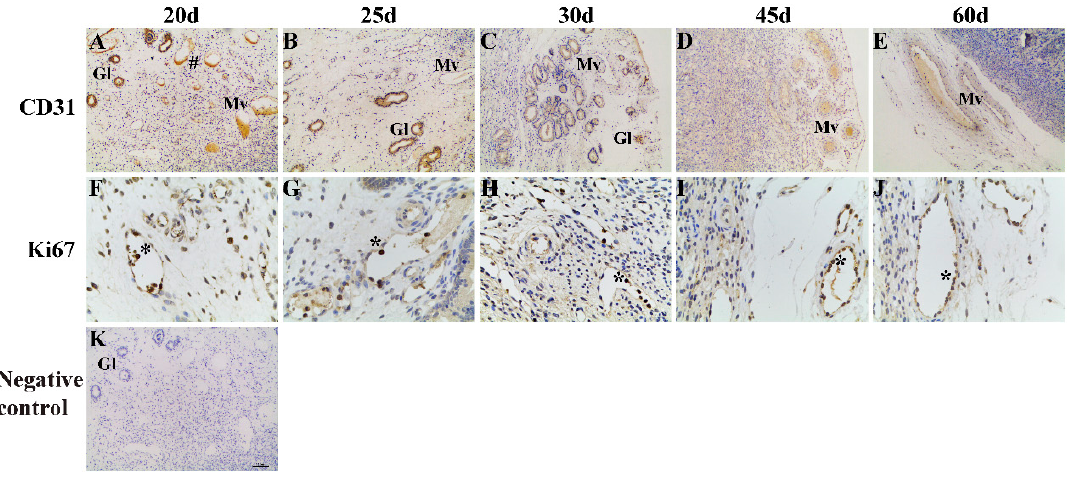
Figure 1. Representative photomicrographs of immunohistochemical staining for CD31 and Ki67 in the goat caruncle. ( A – E ; 100×). Apparent immunoreactive CD31 ‐ positive vessels labeled on days 20 ( A ), 25 ( B ), 30 ( C ), 45 ( D ), and 60 ( E ) of pregnancy. ( F – J ; 400×). Higher density of Ki67 (black arrows) in the nuclei of endothelial and perivascular cells from goats on days 20 ( F ), 25 ( G ), 30 ( H ), 45 ( I ) and 60 ( J ) of pregnancy. ( K ; 100×). Negative control in caruncle on day 20 of pregnancy; no staining was observed. Pound sign indicates staining of CD31 in the caruncle; Mv = maternal vessels; Gl = uterine glands; Asterisks indicate staining of Ki67 in the endothelial and perivascular cells of the caruncle.